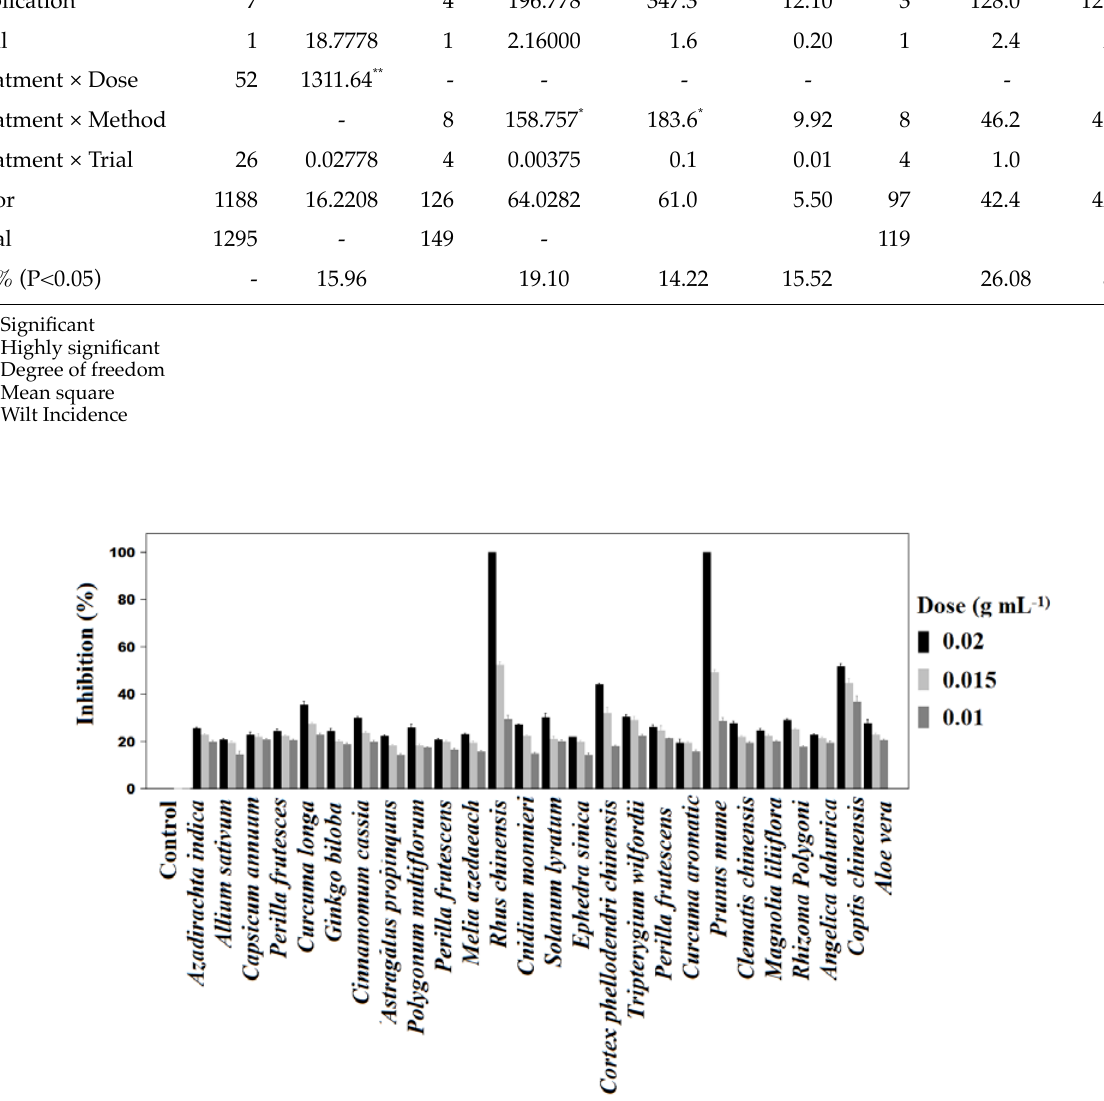
Figure 1. Mean inhibition percentages of mycelial colony growth of Verticillium dahliae by extracts of different Chinese me - dicinal herbs, under in vitro